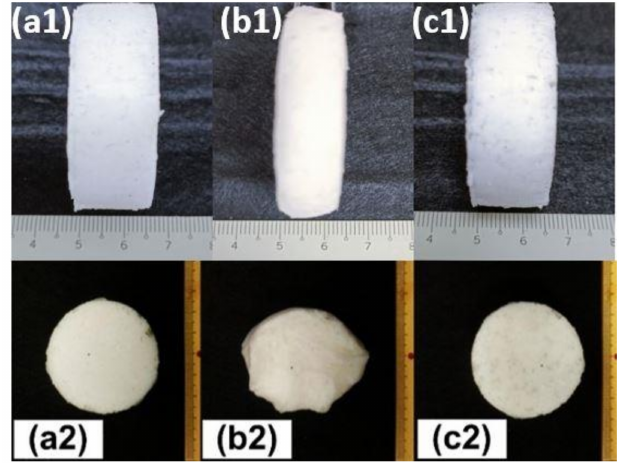
Figure 18. Shape evolution. ( a1 ) original sample, ( b1 ) programmed after compression to 40% strain and ( c1 ) after recovery; ( a2 ) original sample, ( b2 ) programmed by hand squeezing and ( c2 ) after recovery.